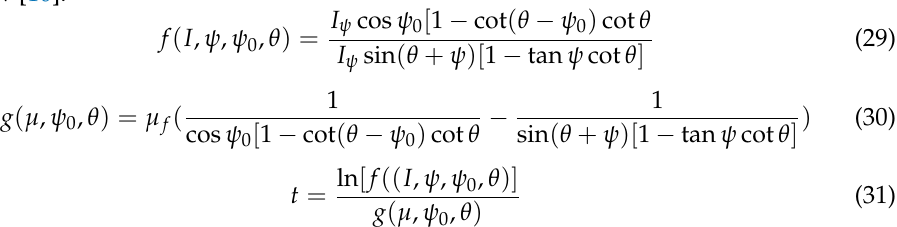
Table 6. XRD conditions in thickness measurement of nickel-coating layer.